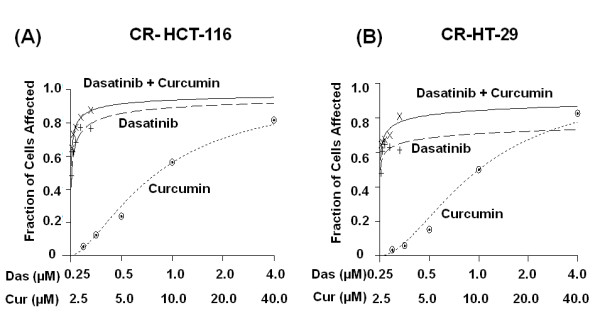
Effects of dasatinib and/or curcumin on the growth of (A) CR HCT-116 and (B) CR HT-29 colon cancer cells: Growth as determined by MTT assay after 72-h incubation with incremental doses of dasatinib and/or curcumin. All CR cells were exposed to 50 μM 5-FU and 1.25 μM oxaliplatin with or without (control) dasatinib and/or curcumin. This treatment strategy was utilized in all subsequent experiments. Dose response curves were generated for the drugs using Calcusyn 2.0 (Biosoft). All assays were performed in quadreplicates. A fractional effect (Fa) of 1 represents complete toxicity for the drug(s), whereas Fa value of "0" indicates no effect.